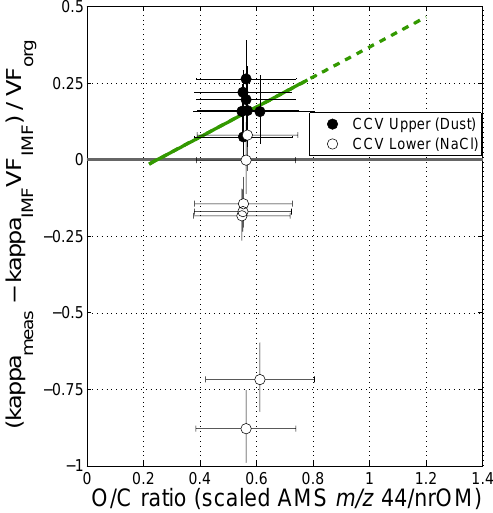
Fig. 8. Estimated κ org vs. O/C ratio. Solid symbols represent the limit in which the mass not chemically resolved by AMS+BC (compared to that estimated from size SMPS distributions) is ap- proximated as dust. Open symbols represent the case where the chemically un-resolved mass is approximated as NaCl. See Fig. 6 for κ meas error description. Y-axis error bars shown here are κ meas /VF org . The error bars shown for the O/C ratio were calcu- lated from the variability in the AMS nrOM and m/z 44 measure- ments ( σn − 0 . 5 for each and sum of squares of relative errors) and combined with a ∼ 35% uncertainty associated with derived O/C ratios with this method (Aiken et al.,